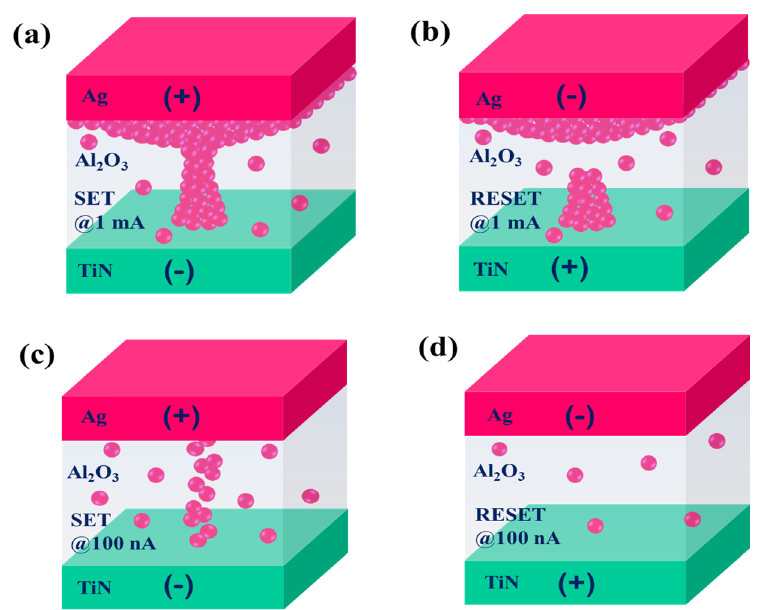
Figure 8. Schematic views of conducting filament growth and dissolution mechanism at different current compliances: ( a ) set at a CC of 1 mA, ( b ) reset after set at 1 mA, ( c ) set at a CC of 100 nA, and ( d ) reset after set at 100 nA.